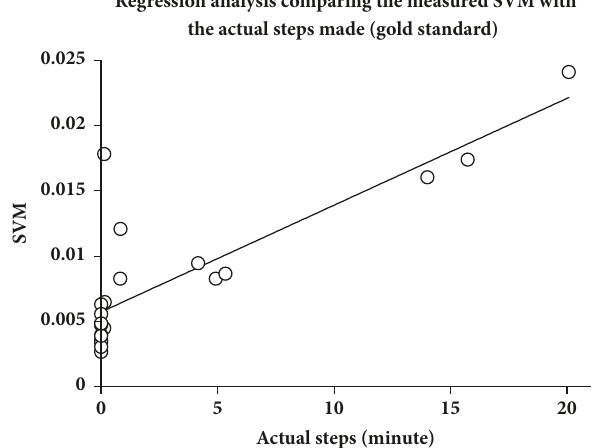
Figure 5: The chart depicts a regression analysis correlating the measuredSignalVectorMagnitude(SVM)withthestepsperminute actually made (gold standard). The steps were recorded by Axivity tracker worn at the lateral femur. 𝑅 2 = 0.68, 𝑛 = 22